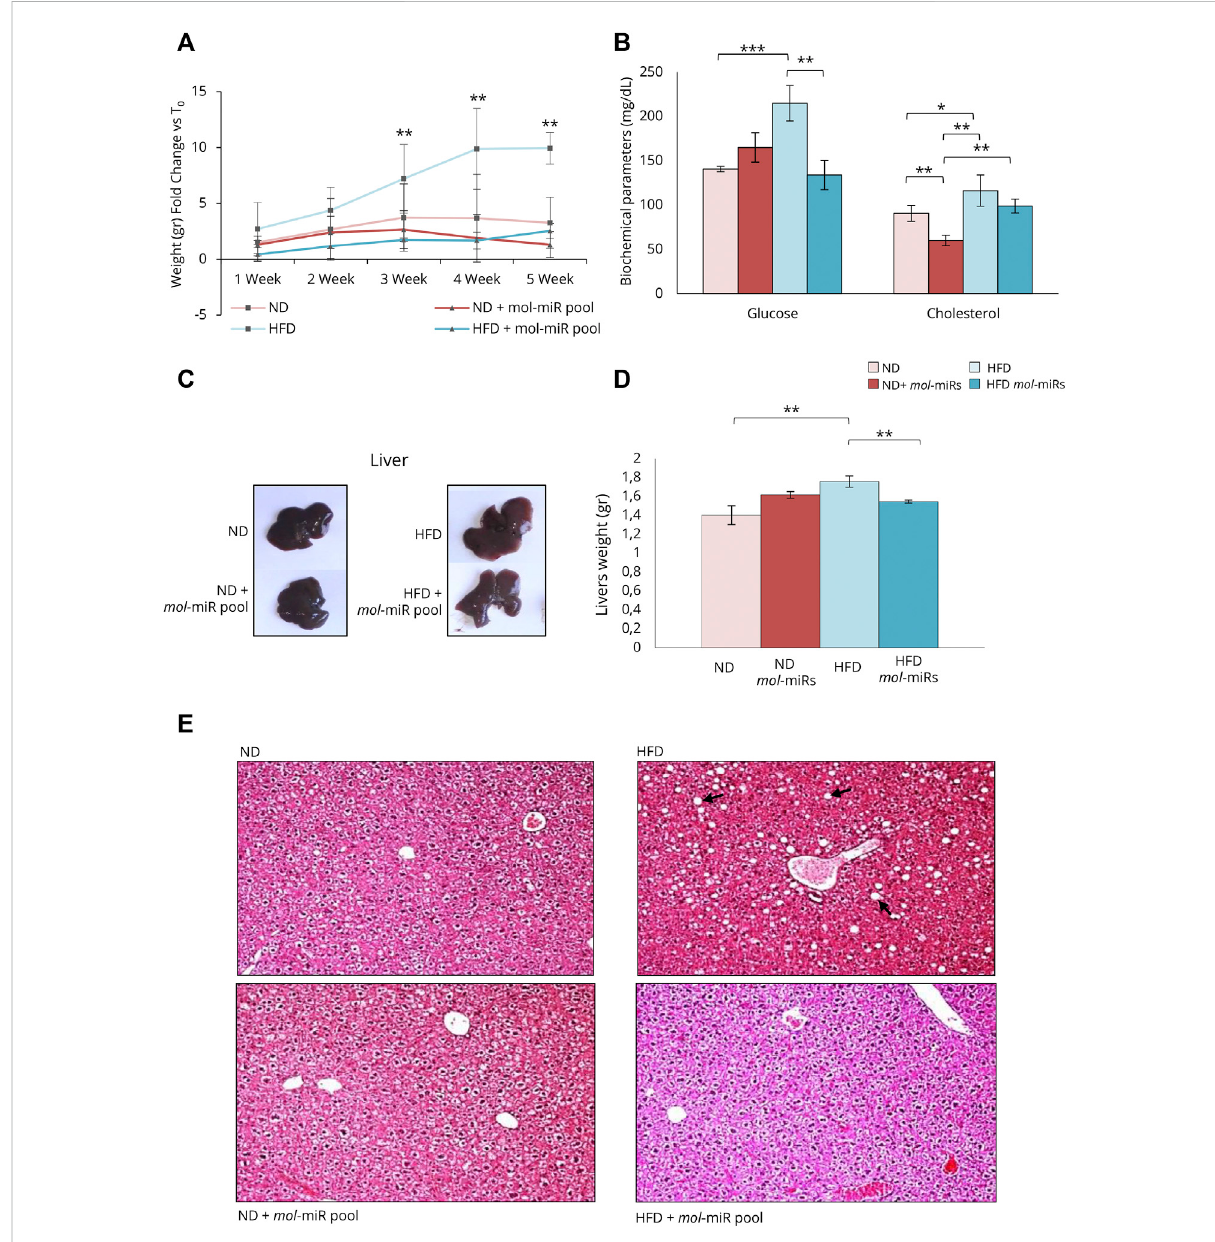
FIGURE 4 Effect of mol -miRpool inmice after High Fat Diet (HFD). (A) Delta ofmouse body weight (grams). The mouse body weightwasmeasuredevery week from the start of the treatment (T 0 ). (B) Biochemical parameters in mice blood measured after 5 weeks. (C) An overview picture of mice livers. (D) Livers weights (grams). Histograms report the mean ± SD ( n = 3 each group, ** p < 0.01). Nonparametric one-way ANOVA corrected by the Kruskal-Wallis test was used. (E) Pictures of H&E staining of liver sections of ND or HFD mice supplemented and not with mol -miR pool. The black arrows in the HFD panel, indicate the lipid droplets accumulated in the